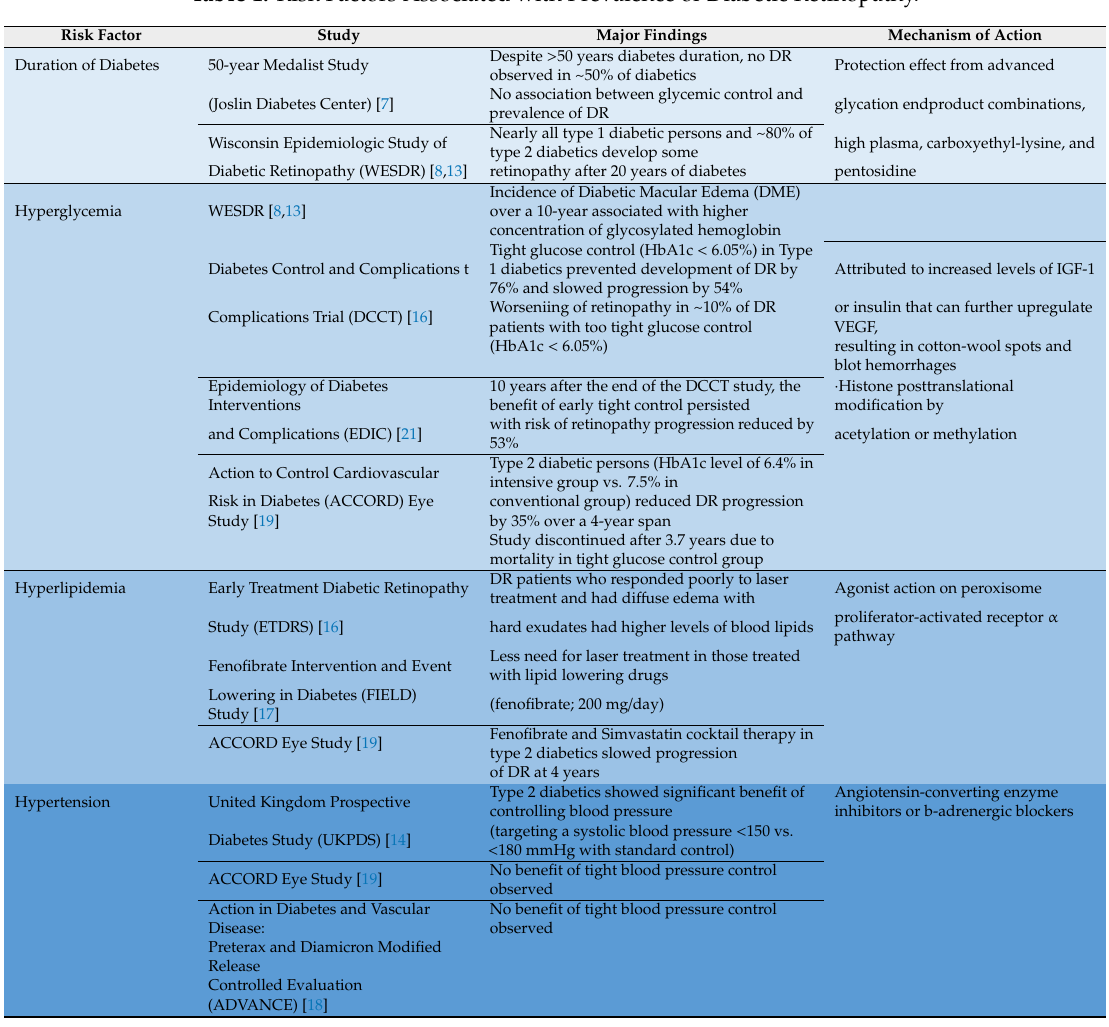
Table 1. Risk Factors Associated with Prevalence of Diabetic